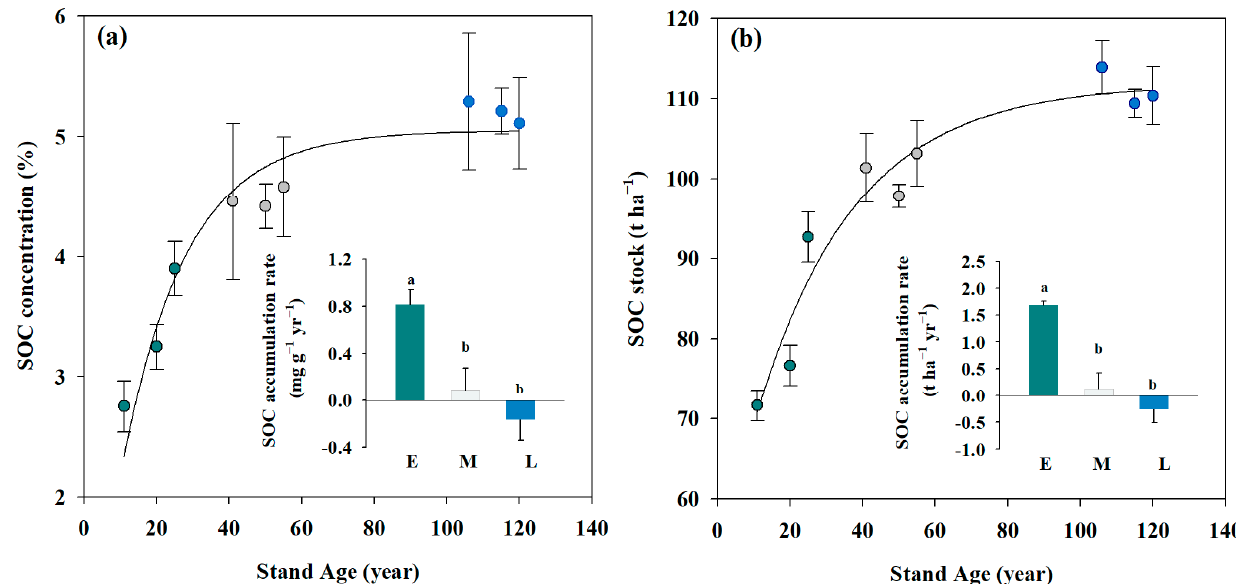
Figure 1. Long-term changes in SOC concentration (panel ( a )) and stock (panel ( b )) in the top 20 cm of soils at three successional stages. Soils were sampled in the years: 2004, 2014, and 2018. Dark cyan dots: measurements in the early-successional forests, gray dots: measurements in the mid-succes- sional forests, and blue dots: measurements in the late-successional forests. The insets in panel ( a , b ) show the SOC accrual rate at each stage of forest succession, where E = early-successional stage, M = mid-successional stage, and L = late-successional stage. The lines shown in Figure 1a and b were fitted to the data. Different lowercase letters indicate significant differences among successional stages, p < 0.05. Dots and bar charts in the figures represent mean values, vertical bars represent the standard error.